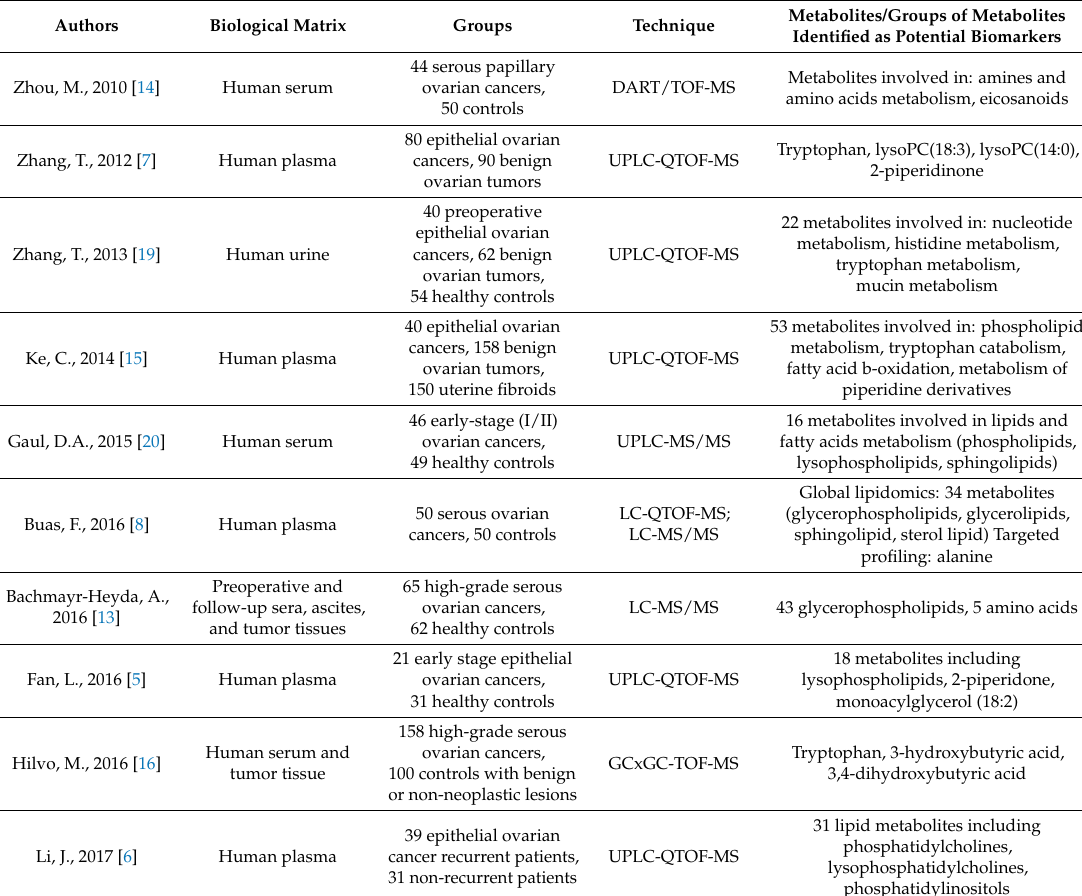
Table 2. Review of recent metabolomic studies on OC